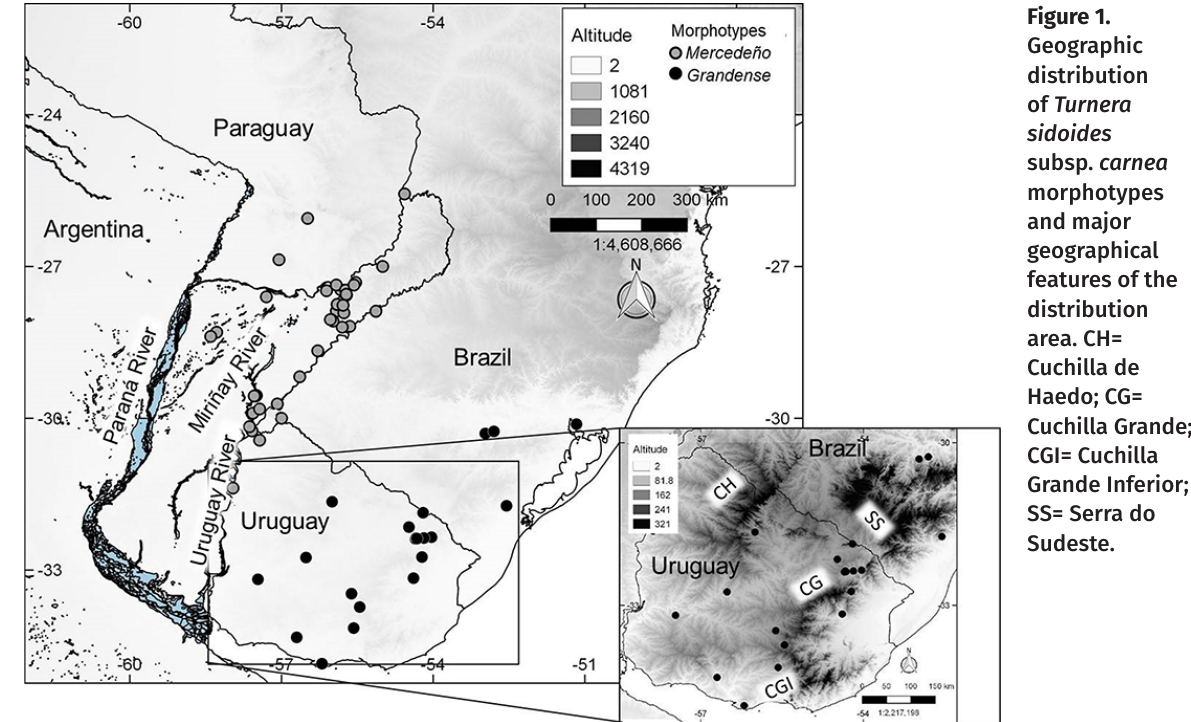
Figure 1. Geographic distribution of Turnera subsp. carnea morphotypes